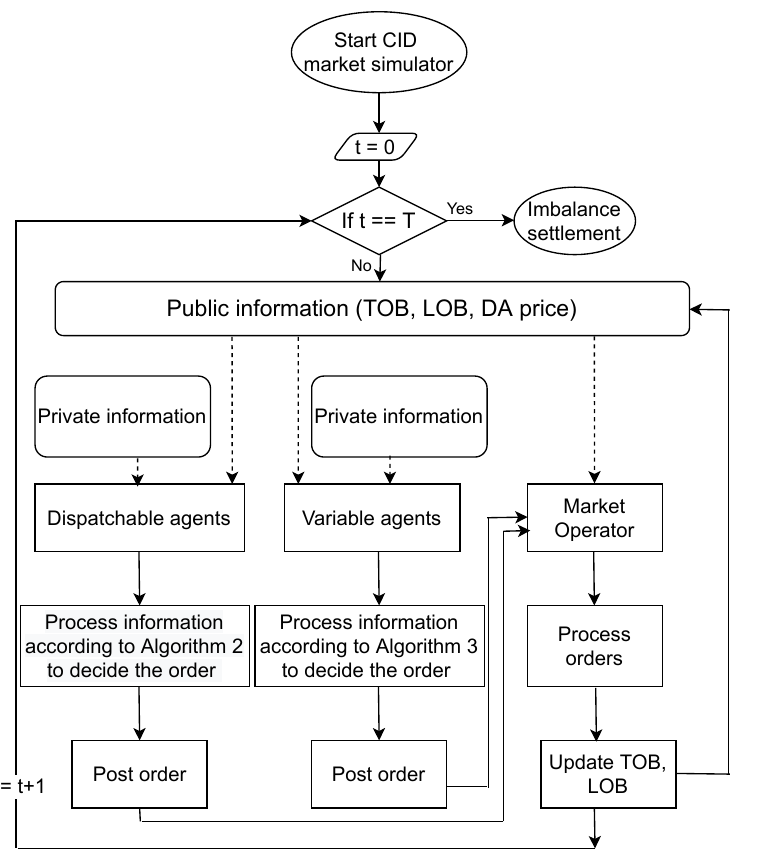
Figure 3. Overview of CID market